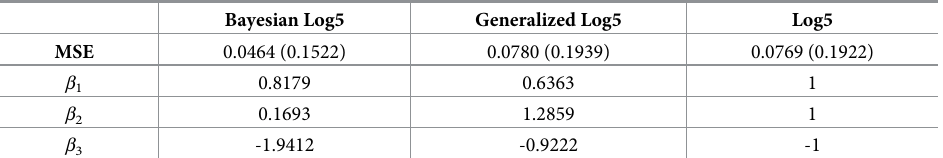
Table 2. Comparison of the Bayesian hierarchical log5, generalized log5, and log5 models in terms of MSE and the average of estimated coefficients.